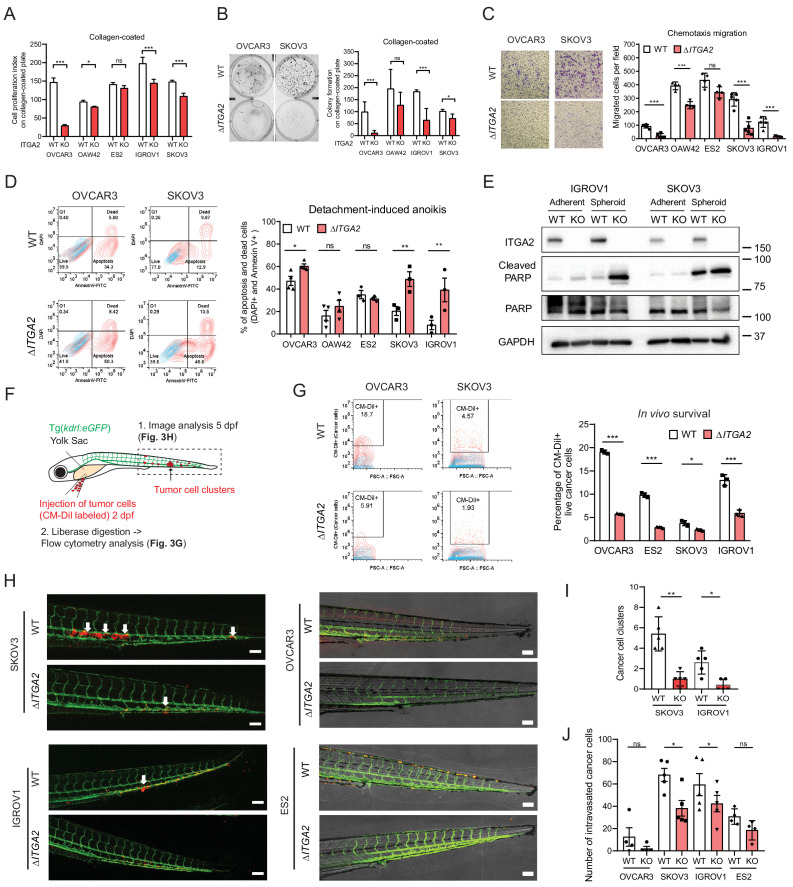
ITGA2 promotes EOC cell migration, anoikis resistance, and extravasation in vitro and in vivo.(A) Cell proliferation index of WT and ΔITGA2 cells in collagen-coated plate. (B) Anchorage-dependent colony formation assay for WT and ΔITGA2 cells on collagen-coated plate after 7 days incubation. Bar chart represents the mean ± SD of total colony counts. (C) Chemotaxis cell migration assay and quantification of cell migration (24 hr). Scale bar 200 μm. (D) Cell detachment-induced apoptosis (anoikis) assay. WT and ΔITGA2 cells stained with Annexin V-FITC and DAPI after 3–5 days of cultivation in ultra-low attachment plate to identify apoptotic dead cells (FITC+/DAPI+). Mean ± SD (*p<0.05) from two independent experiments. (E) Western blot shows increased cleaved PARP in the KO compared to WT cells under non-adherent spheroid condition. (F) Scheme of tumor cells transplant model in Tg(kdrl:eGFP) zebrafish. CM-Dil labeled cancer cells were transplanted into zebrafish at two dpf (days post fertilization). (G) At five dpf, fish were enzymatically dissociated to single cells and analyzed in vivo survival of cancer cells by flow cytometry. Representative counter plot shows the percentage of CM-Dil+ cancer cells. Bar chart summarizes data from n = 5 fish per group. (H) Representative confocal images of transplanted fish (n = 5 per group) showing the tumor cluster formation in proximity of the circulatory loop (white arrow) at five dpf. Scale bar 100 μm. (I) Numbers of cluster formation and (J) single cells in tail vein were counted and represented as mean ± SD (unpaired Student’s t-test, *p<0.05).